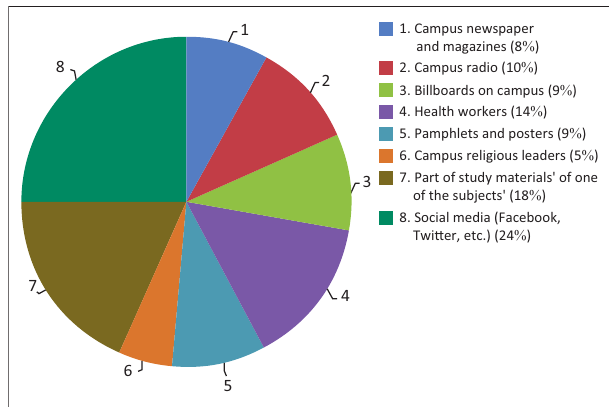
FIGURE 1: Preferred method of HIV and/or AIDS information